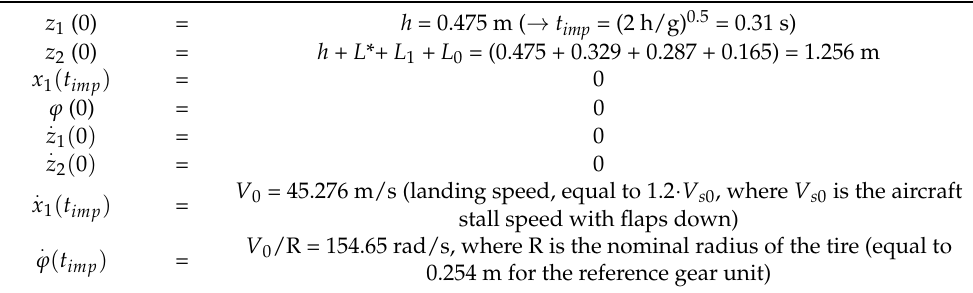
Table 1. Initial conditions used for integration of drop dynamic equations.